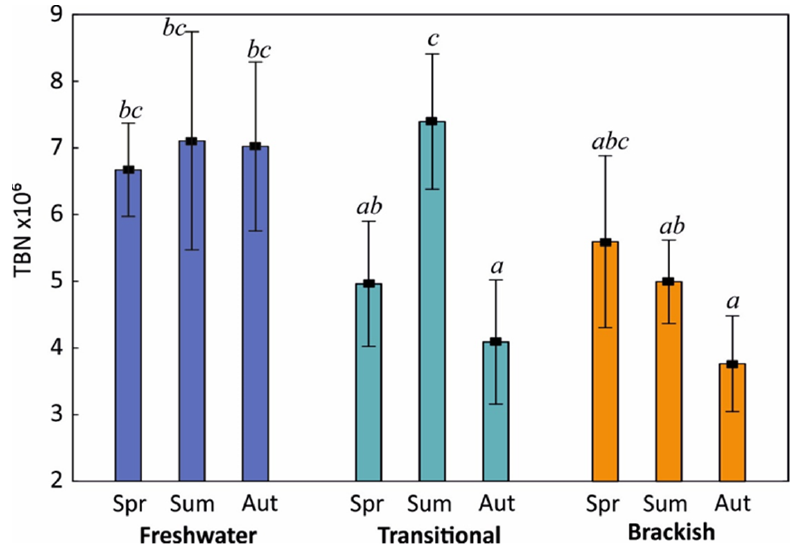
Figure 3. Changes in TBN (×10 6 cells/mL) in relation to lake types and seasons. Different superscript letters indicate statistically significant differences between the groups of lakes (two-way ANOVA, Tukey’s HSD test ( p < 0.05) as a post hoc procedure).